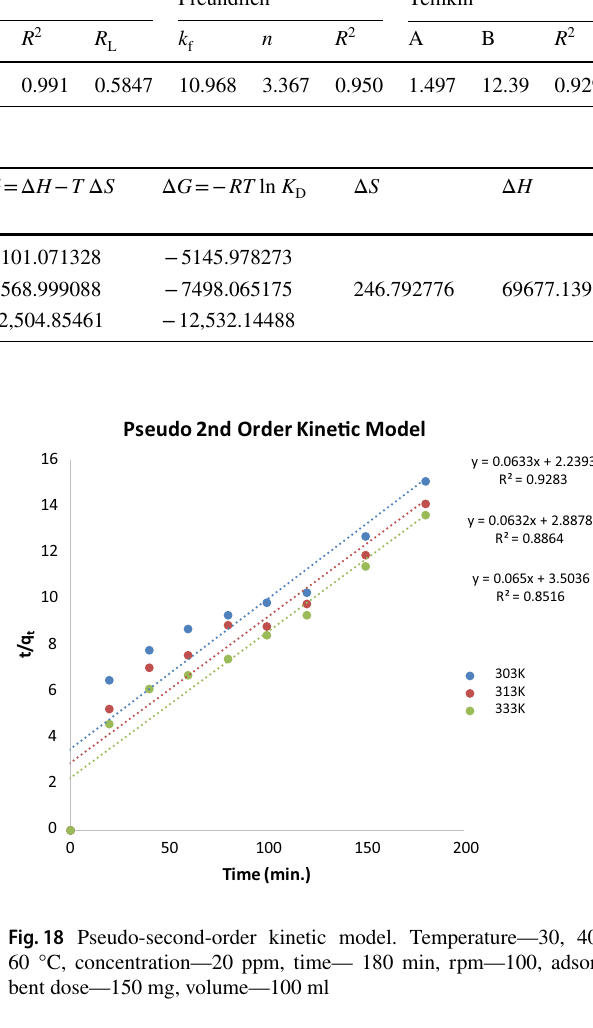
Table 3 Isotherm parameters for removal of CR dye